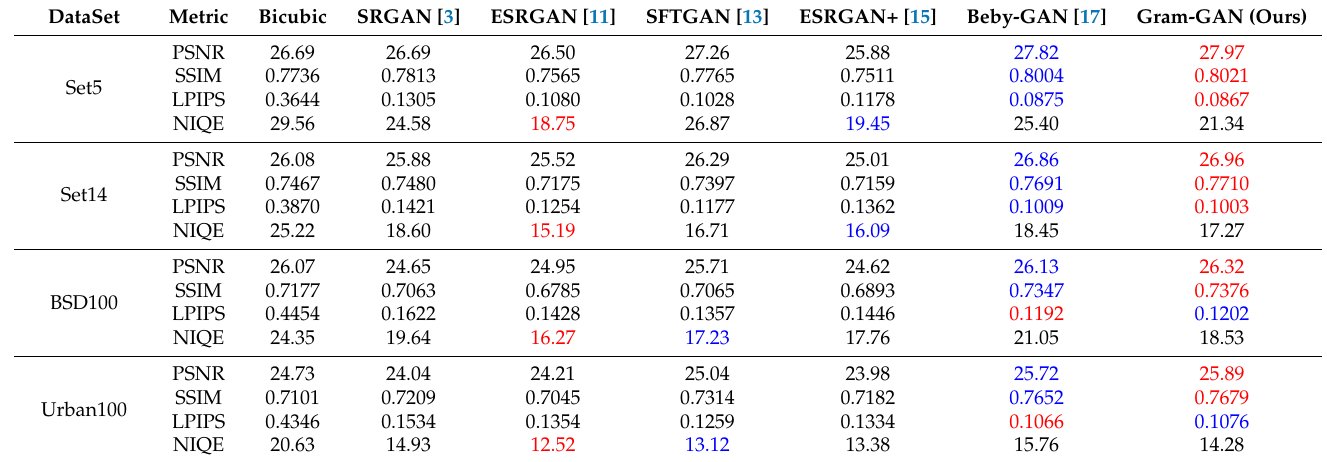
Table 1. Quantitative evaluation of state-of-the-art perception-driven